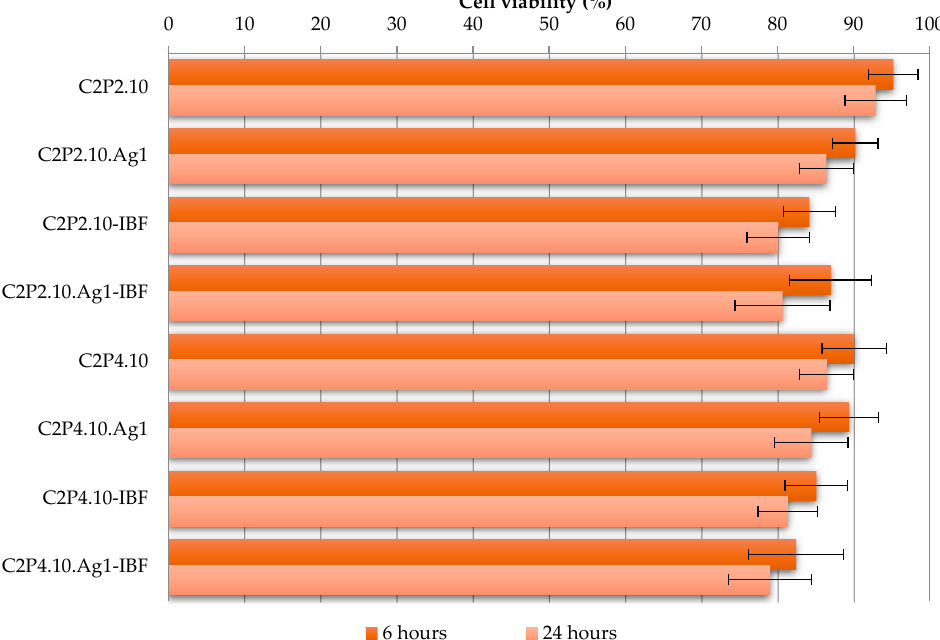
Figure 10. In vitro cells viability of obtained films at 6 h and 24 h after incubation.